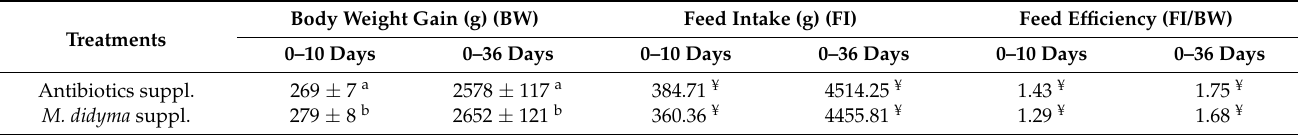
Table 5. Comparison of mean body weight gain (g), feed intake (g), and feed efficiency of the broiler treatments. Treatments Antibiotics